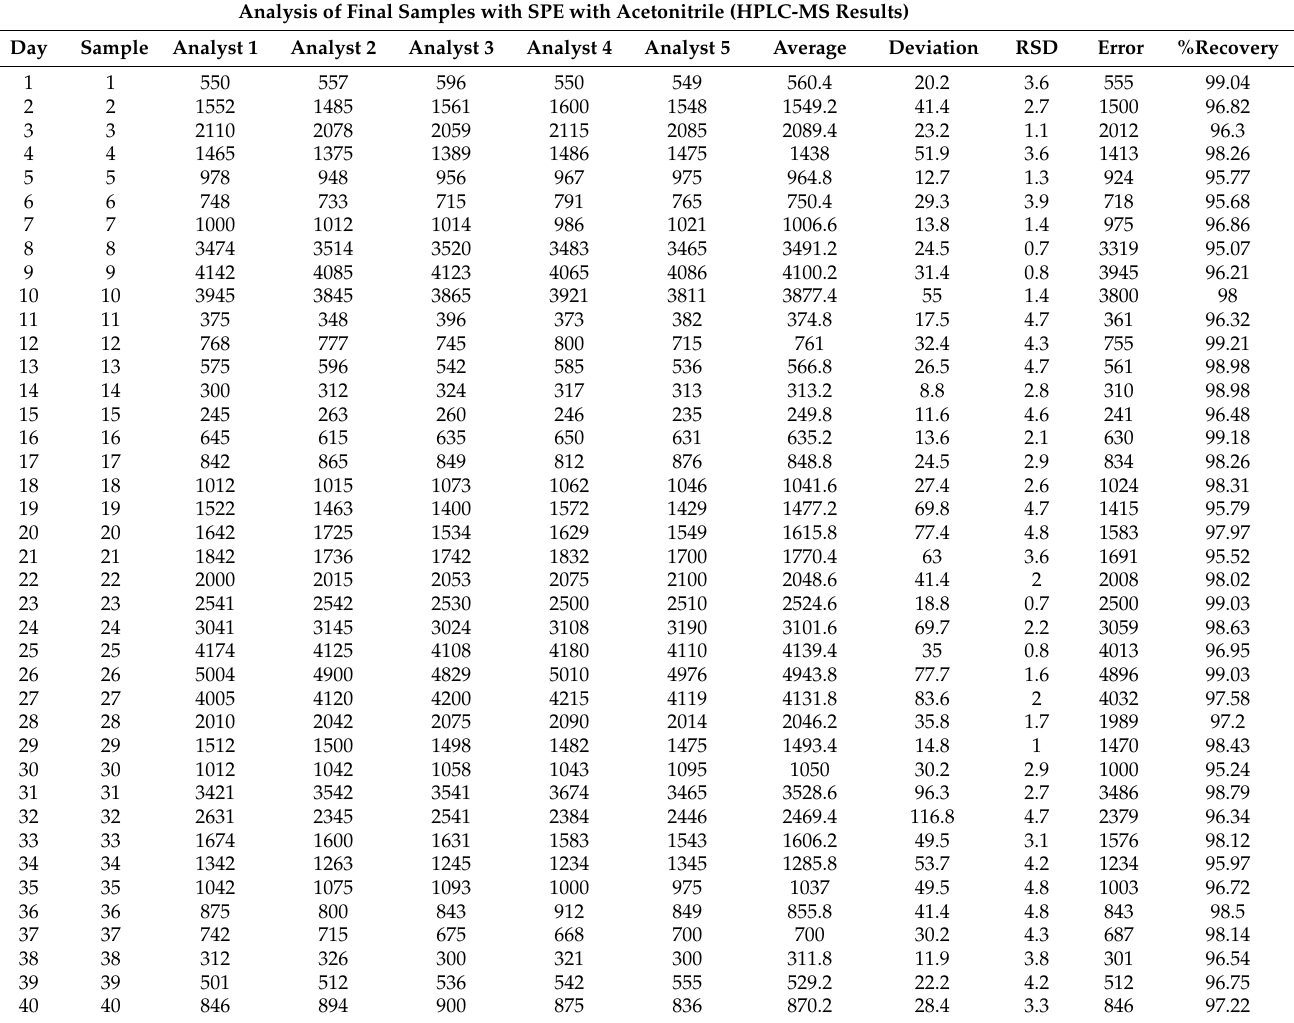
Table 4. Data tabulation for sample